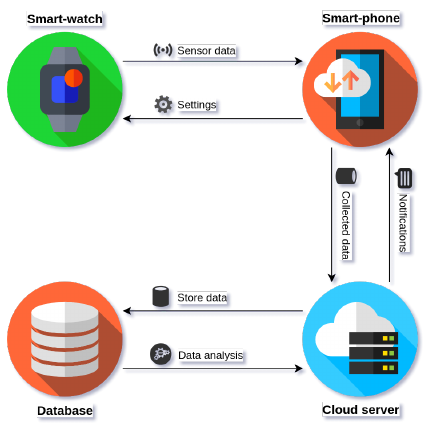
Figure 2. Senior monitoring IPS overview. The smartwatch sends sensor data to the smartphone. An application installed on the smartphone is the interface through witch the user or the caregiver configures the smartwatch. The smartphone sends the data to a cloud server. The server performs data analysis and can communicate with the user through notifications. (Icons made by Freepik from